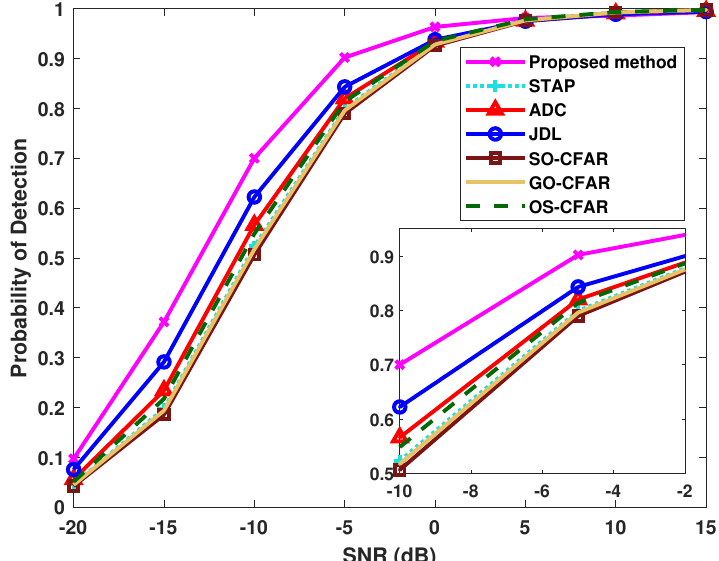
Figure 1. Comparison of detection probabilities with various